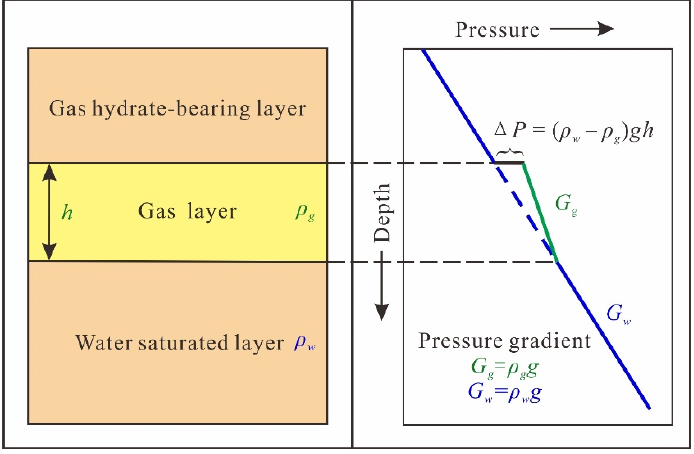
Figure 4. Schematic diagram to show buoyancy related overpressure development in gas hydrate occurrence area (modified from Zhang [38]).